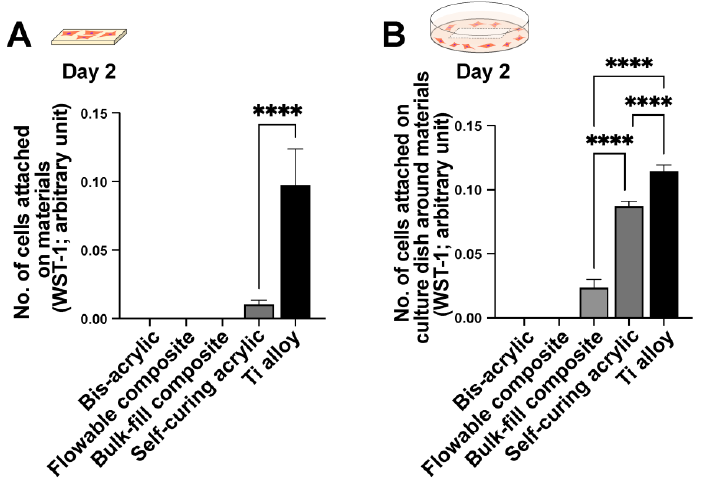
Figure 1. Initial attachment of fibroblasts to and around various dental restorative materials. Tita- nium alloy was used as a control. Contact ( A ) and proximity ( B ) experiments were performed. The WST-1 assay was performed on culture day two to quantify the number of cells attached to each material ( A ) and in the culture well around each material ( B ): **** p <